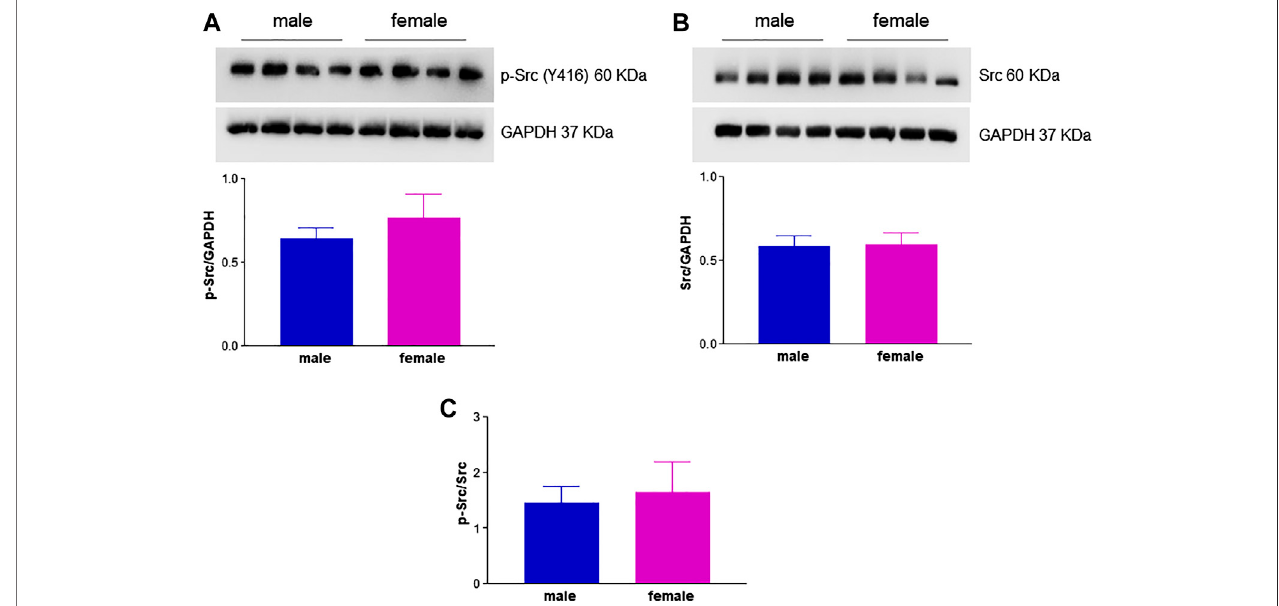
FIGURE 8 | Effect of HUVEC donor ’ s sex on Src activation. HUVECs were seeded in 35-mm dishes in M199 complete medium. (A,B) Upper panels : Representative Western blots showing the expression of p-Src (Y416) and total Src, respectively; GAPDH was used as loading control. Lower panel : Densitometric analysis of bands normalized to GAPDH levels. (C) p-Src/Src ratio. Each independent experiment ( n (cid:1) 3) was performed using cells from four male and four female donors. Data are shown as mean ± SEM of 12 male and 12 female donors. t -test, ns.